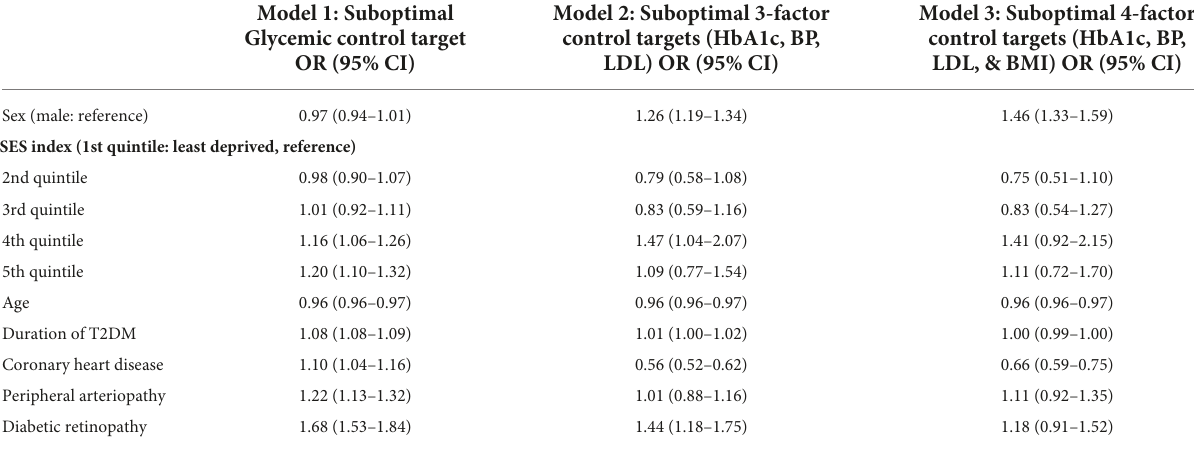
TABLE 4 Factors associated with suboptimal glycemic and multifactorial control targets (aORs and 95% CI). Model 1: Suboptimal Model 2: Suboptimal 3-factor Glycemic control target control targets (HbA1c, BP, OR (95% CI) LDL) OR (95% CI)